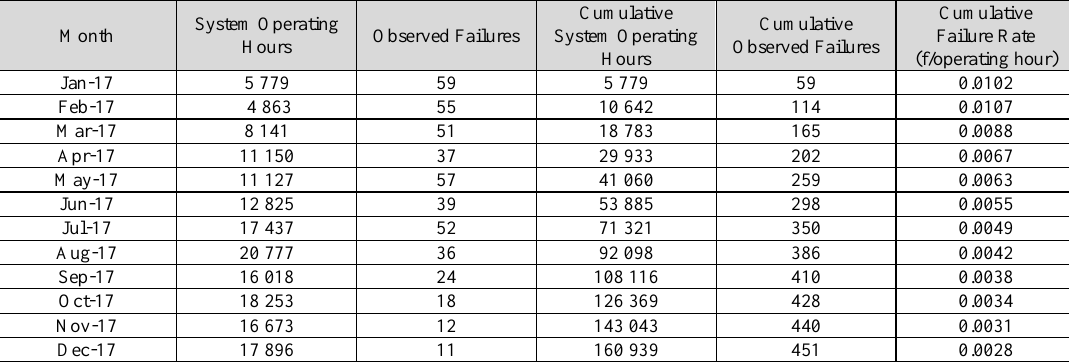
Table 1. System field failure data distribution